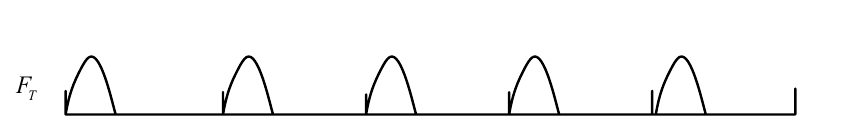
Figure 12. Torsional excitation diagram of shafting during one rotation